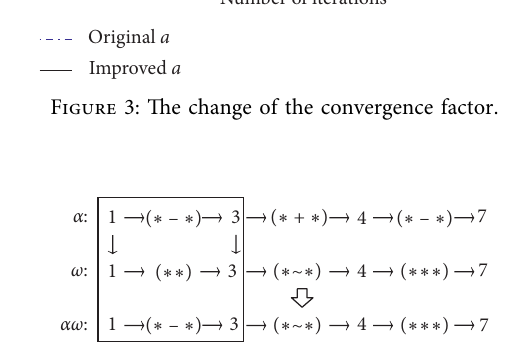
Figure 4: The update mode of the transportation plan.